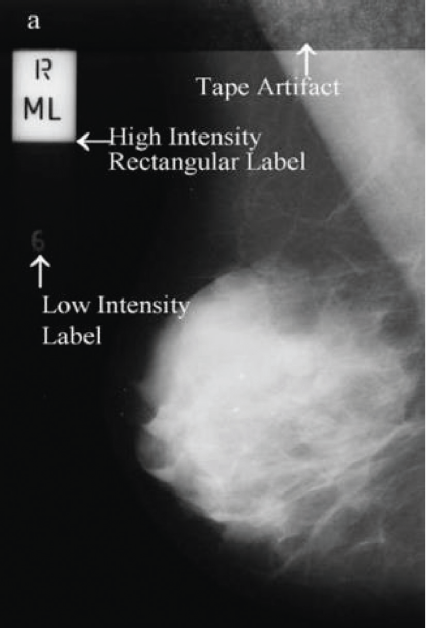
Figure 3: Mammogram image with various